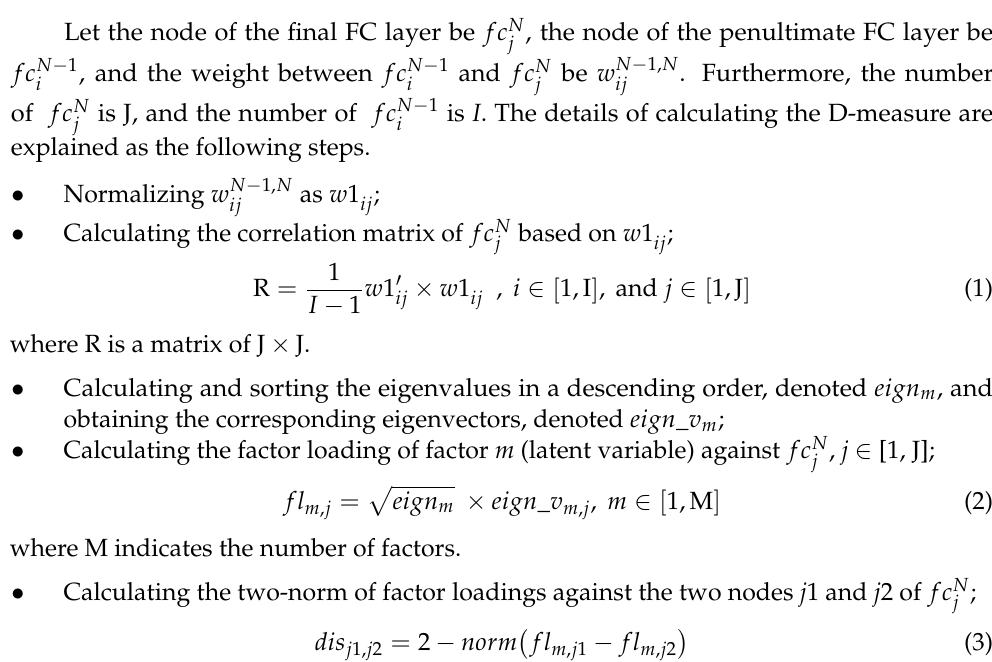
Figure 2. Flowchart of defining D-measure.